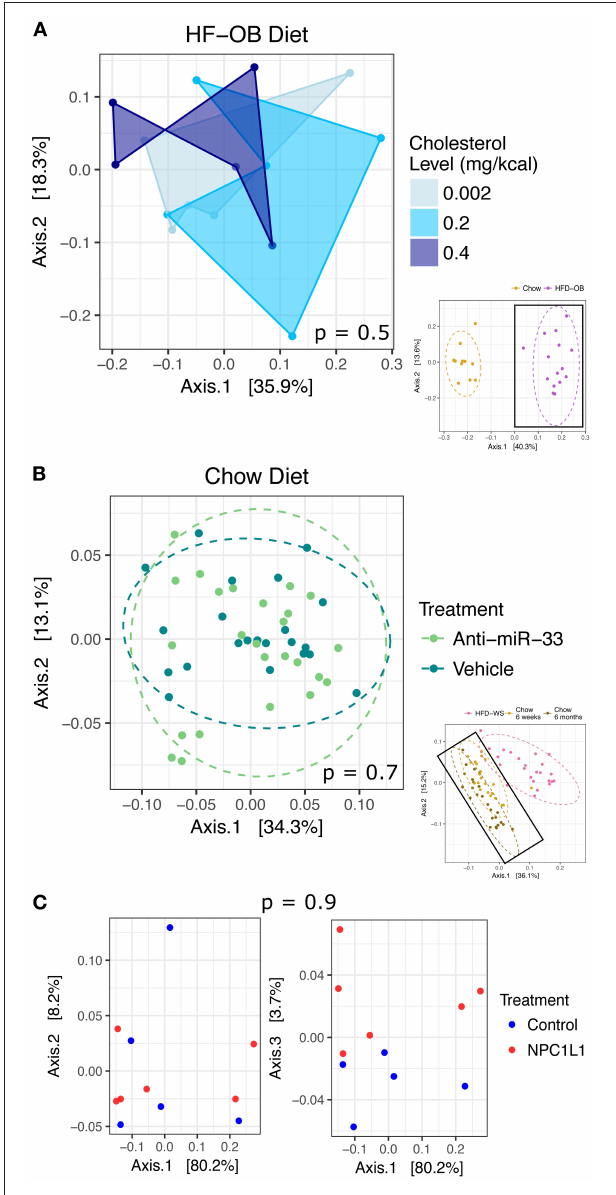
FIGURE 4 | Treatments with no or minimal effect on the microbiome. Results were plotted using principal coordinate analysis with weighted Unifrac distance, and groups were compared using non-parametric multivariate analysis of variance (PERMANOVA). There was no effect in the (A) High-fat Oleic Blend study due to dietary cholesterol level and in the (B) Recovery from High-fat Diet study due to Anti-miR-33. There was a slight effect in the (C) Biliary Cholesterol study from NPC1L1 visible on Axis 3. Large ordinations represent samples enclosed in the bolded boxes of the thumbnail ordinations. Dashed ellipses represent 95% CI from the cluster